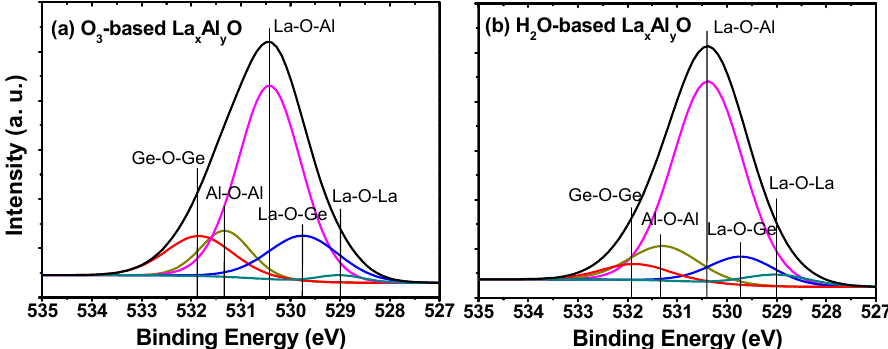
Figure 1. Shallow core-level spectra of O 1 s for the 5 nm ( a ) O 3 -based and ( b ) H 2 O-based La x Al y O films.